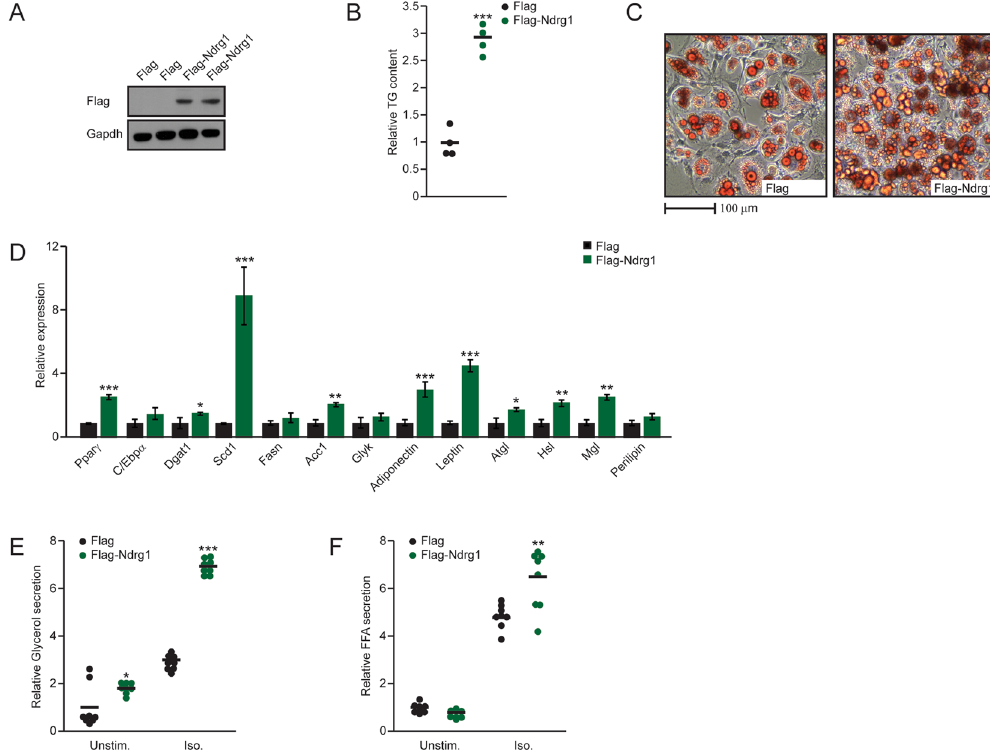
Figure 3. Overexpression of Ndrg1 promotes adipogenesis. ( A ) Western blot using indicated antibodies on extracts isolated from 3t3l1 control and FlagNdrg1-expressing cells. ( B ) Relative TG content and ( C ) neutral lipid staining (OilRedO) of differentiated 3t3l1 control and FlagNdrg1-expressing cells. ( D ) Relative mRNA levels for indicated genes in differentiated control and Ndrg1-overexpressing 3t3l1 cells. ( F ) Relative glycerol and ( G ) FFA levels in medium from differentiated 3t3l1 control cells or Ndrg1-overexpressing cells stimulated with control medium or Iso. Each data point represents a biological replicate (for bar plots n = 3). Stars indicate significance for given parameters between control and Ndrg1- overexpressing cells. ( * P < 0.05, ** P < 0.01, *** P < 0.001 according to ANOVA followed by the Post hoc Tukey